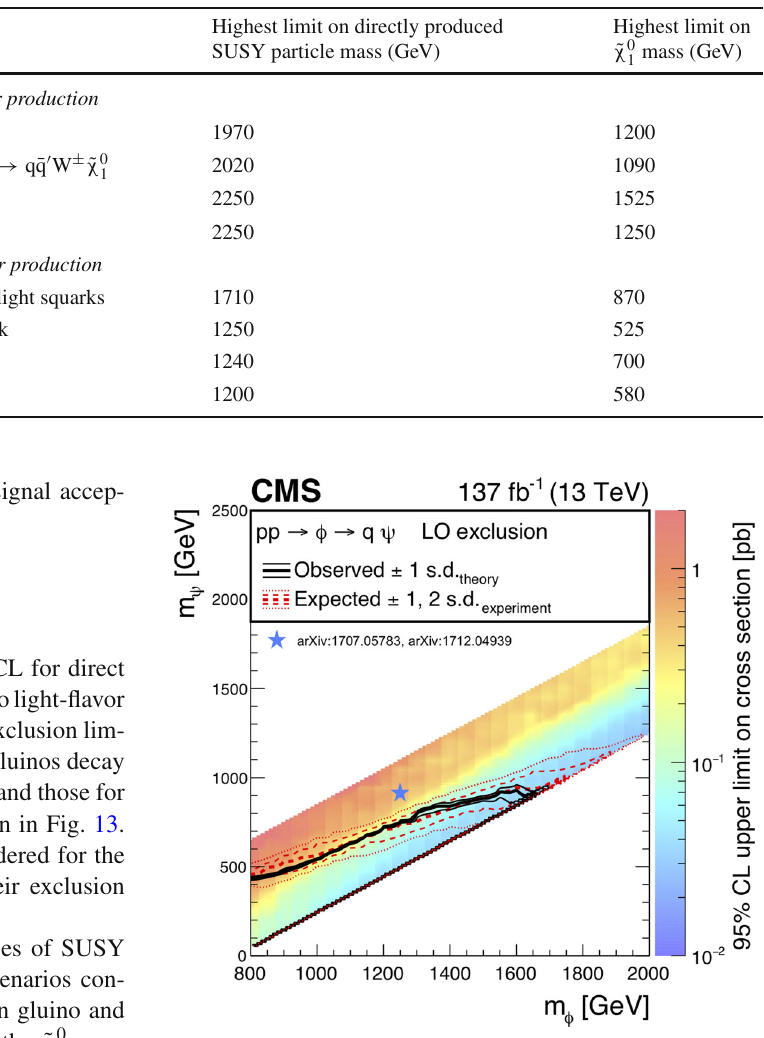
Fig. 15 Exclusion limit at 95% CL for the mono- φ model. We con- sider the mass range where such a model could be interesting based on a reinterpretation of previous analyses [35,36]. The area enclosed by the thick black curve represents the observed exclusion region, while the dashed red lines indicate the expected limits and their ± 1 and ± 2 standard deviation (s.d.) ranges. The thin black lines show the effect of the theoretical uncertainties in the signal cross section. The blue star (cid:2) (cid:3) = ( 1250 , 900 ) GeV indicates the best fit mass point m φ , m ψ at reported in Refs. [35,36]. Signal cross sections are calculated at LO order in α